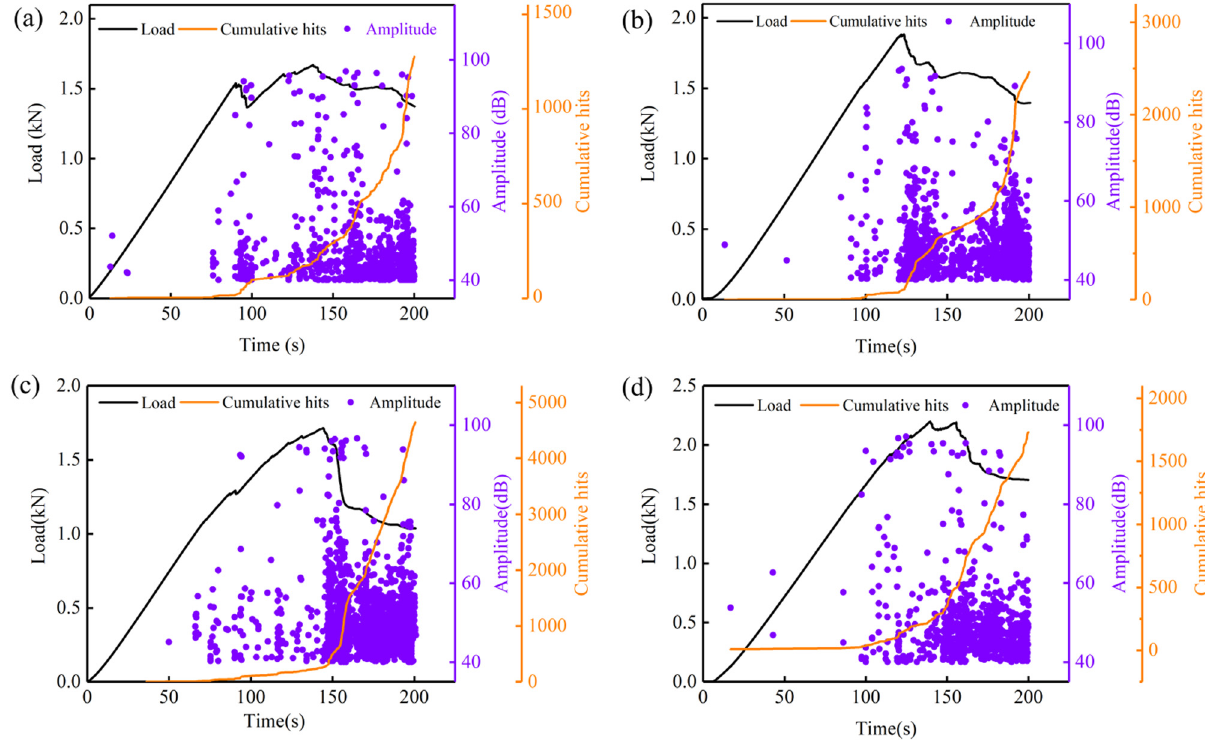
Figure 6: Variation of mechanical and AE characteristic parameters of di ff erent specimens with time. ( a ) – ( d ) Specimens A –